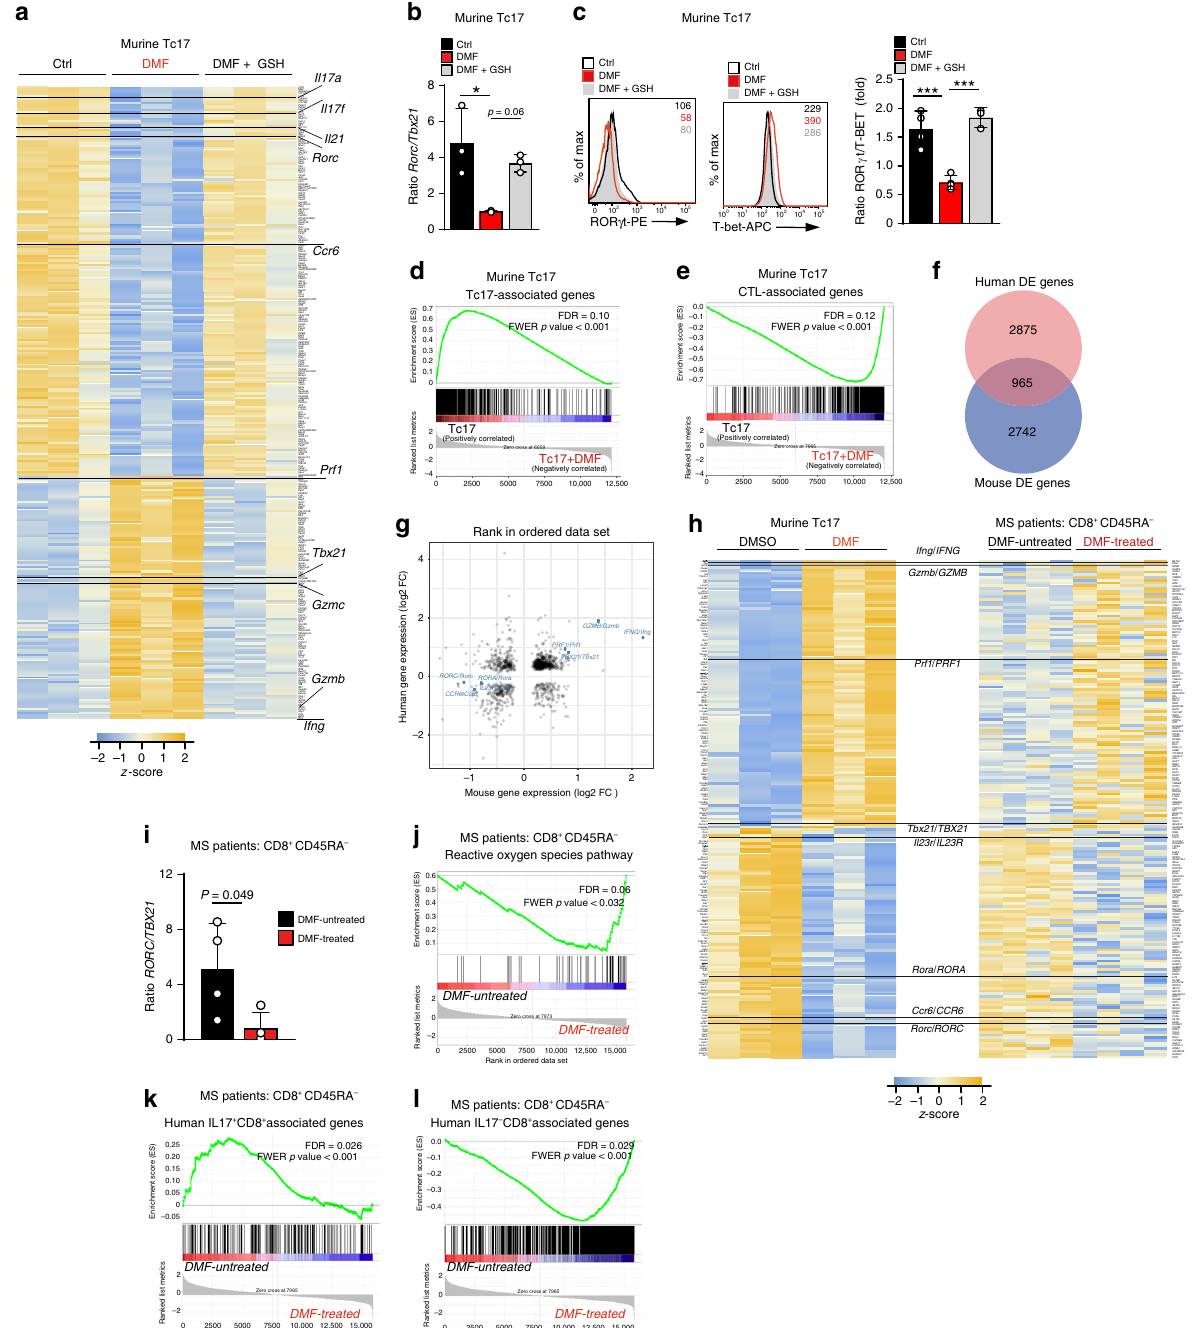
(Supplementary Fig. 3e). In line with published data 39 , inhibition of mTOR signaling by rapamycin blocked IL-17 production in pathogenic Th17 cells (Supplementary Fig. 3f), in contrast